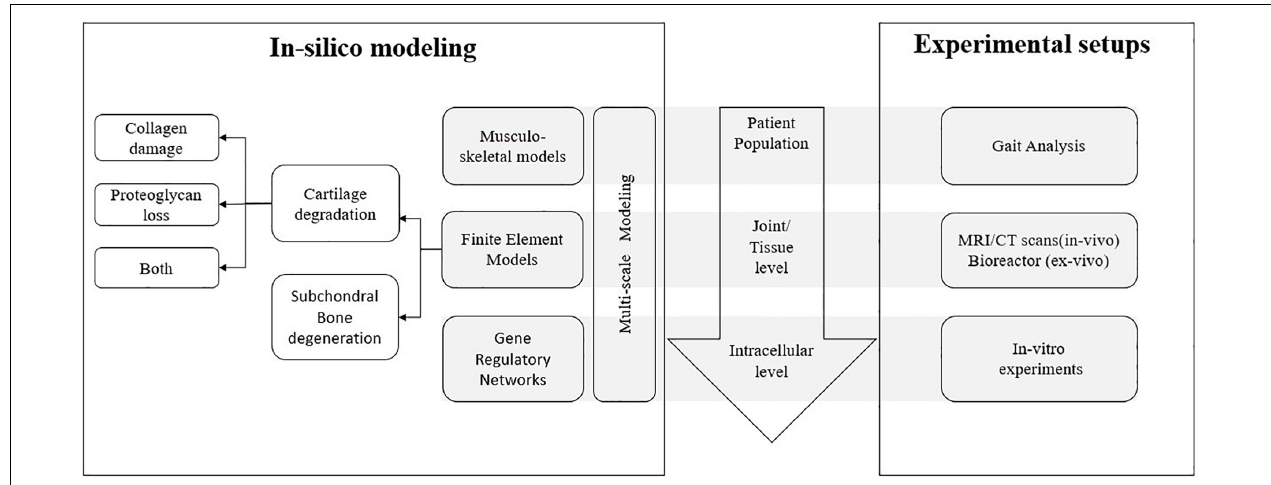
FIGURE 2 | Overview of different aspects of joint degeneration with the different length scales involved and the link between in silico mechanistic modeling and corresponding experimental setups for each